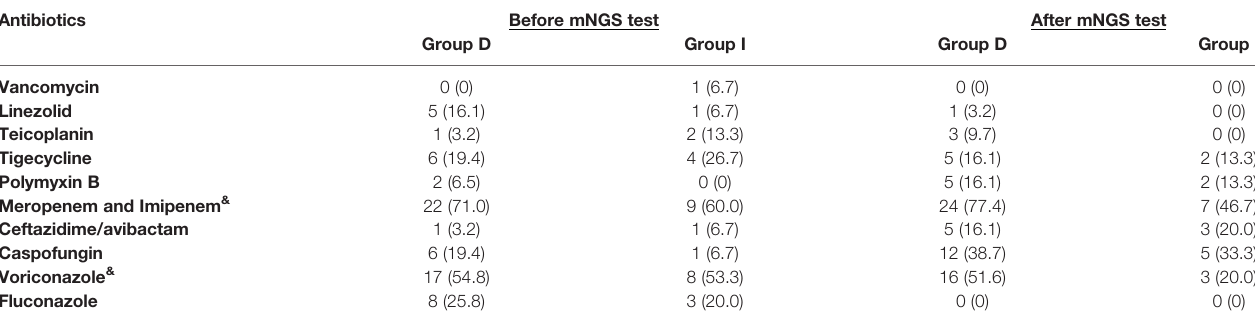
TABLE 4 | Pathogens detected by mNGS and routine test of immunocompromised patients supported with vv-ECMO. Antibiotics Before mNGS test After mNGS test Group D Group I Group D Group I Vancomycin 0